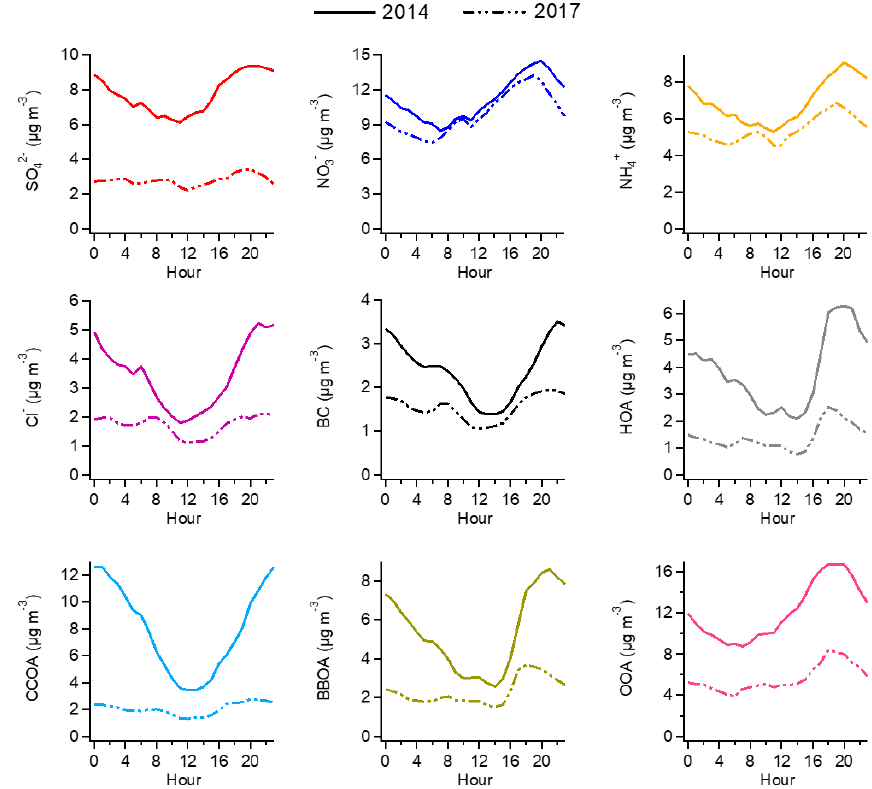
Figure 2. Average diurnal cycles of different aerosol species in the winter of 2014 (solid line) and winter of 2017 (dashed line).